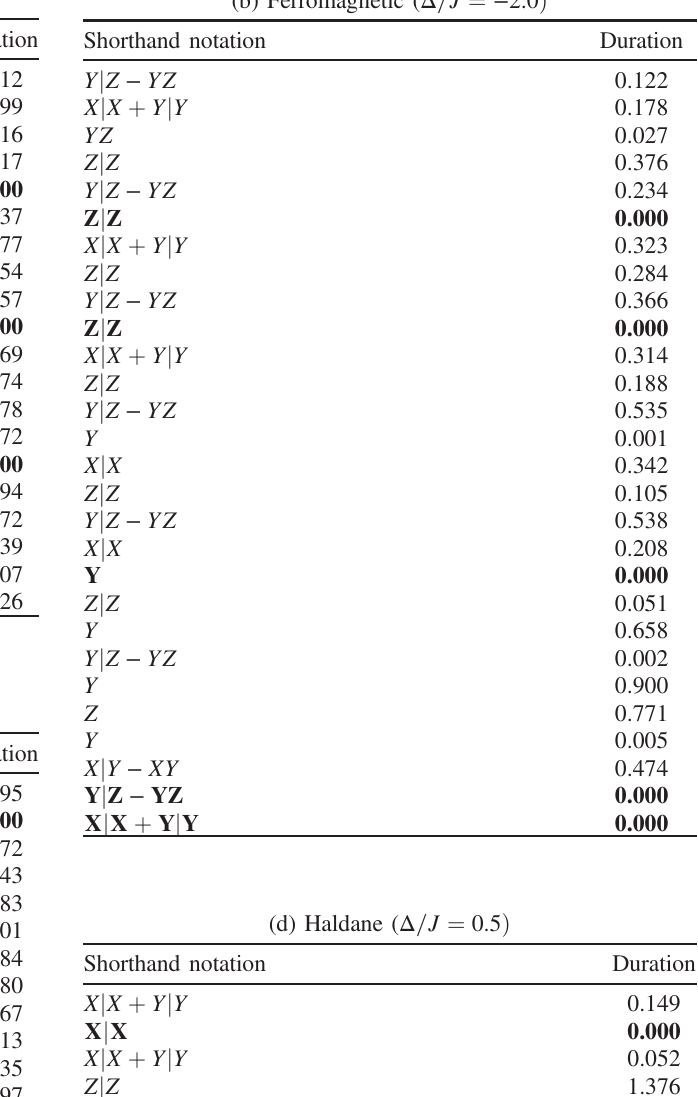
(a) Ising spin-1 (b) Ferromagnetic ( Δ =J ¼ − 2 . 0